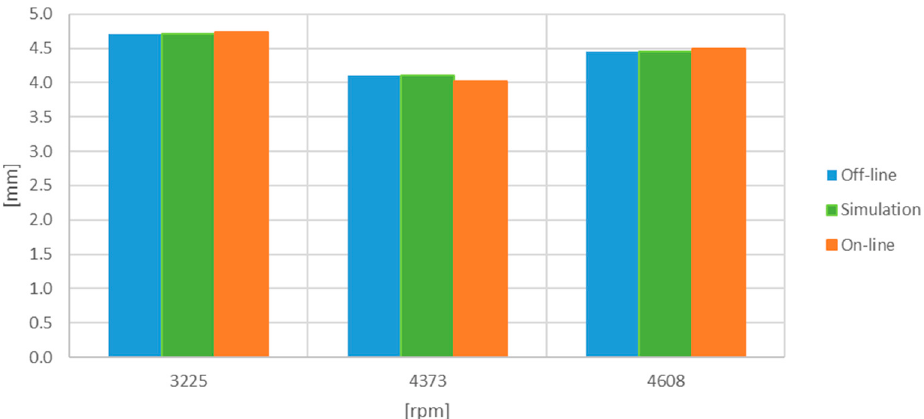
Figure 11. Minimum TC [mm] obtained with the one-turn-original set of signals.